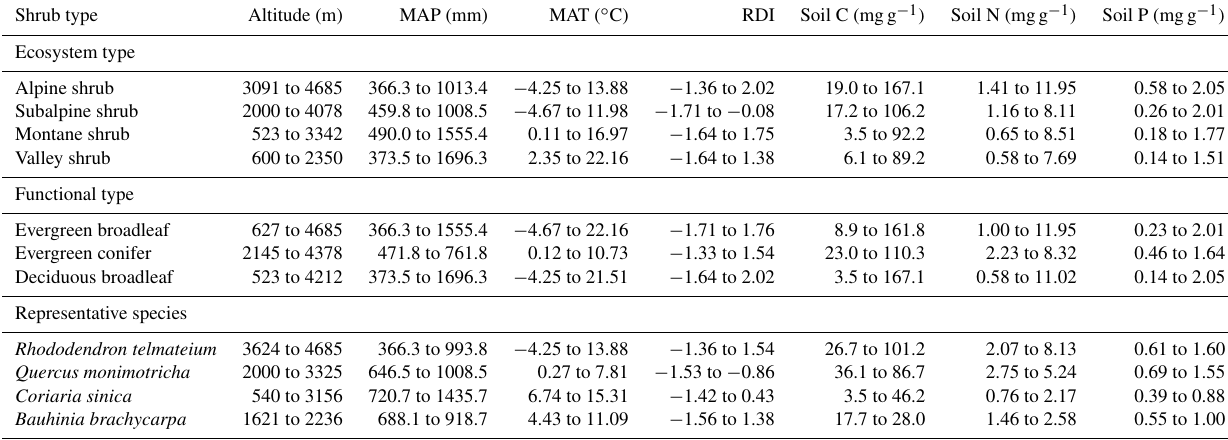
Table A1. Geographical, climatic and soil nutrient information of different shrub types and representative dominant shrub species on the Tibetan Plateau.